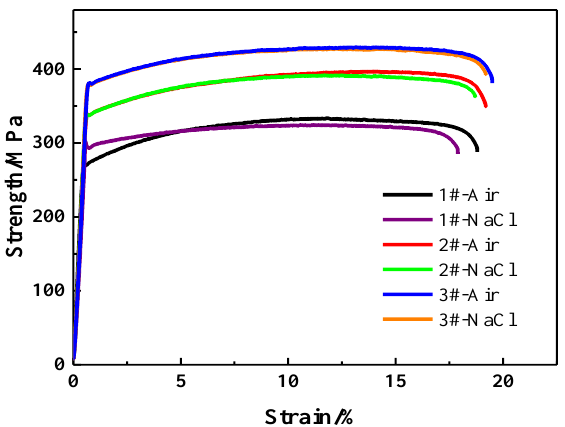
Figure 8. Slow strain rate testing (SSRT) curves for three alloys (ED direction on ED–TD plane): ( a ) in air; ( b ) in 3.5 wt% NaCl solution. Table 5. Slow strain rate test (SSRT) results (ED direction on ED – TD plane) of alloys with different Zn/Mg ratios.